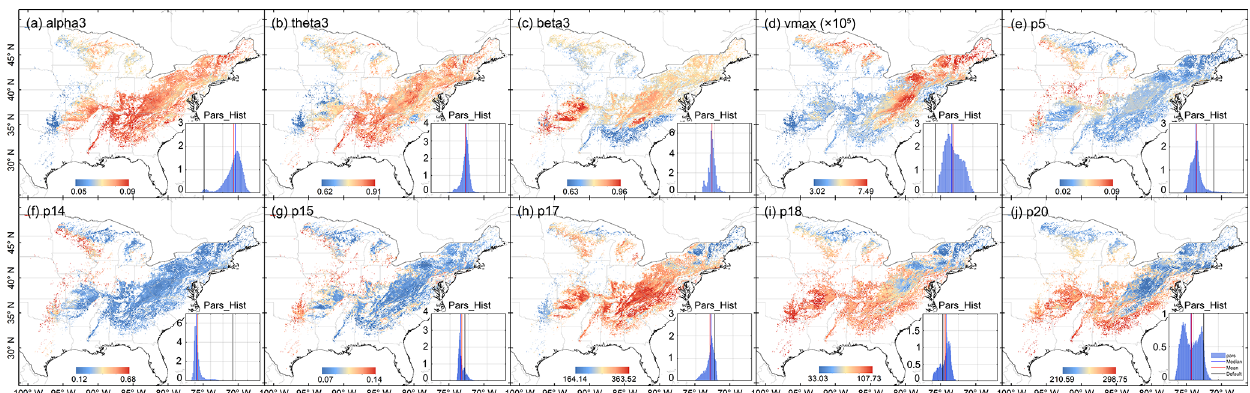
Figure 7. Spatial distribution of posterior parameter. The inset in the lower right corner of each plot represents the spatial distribution histogram of each parameter.